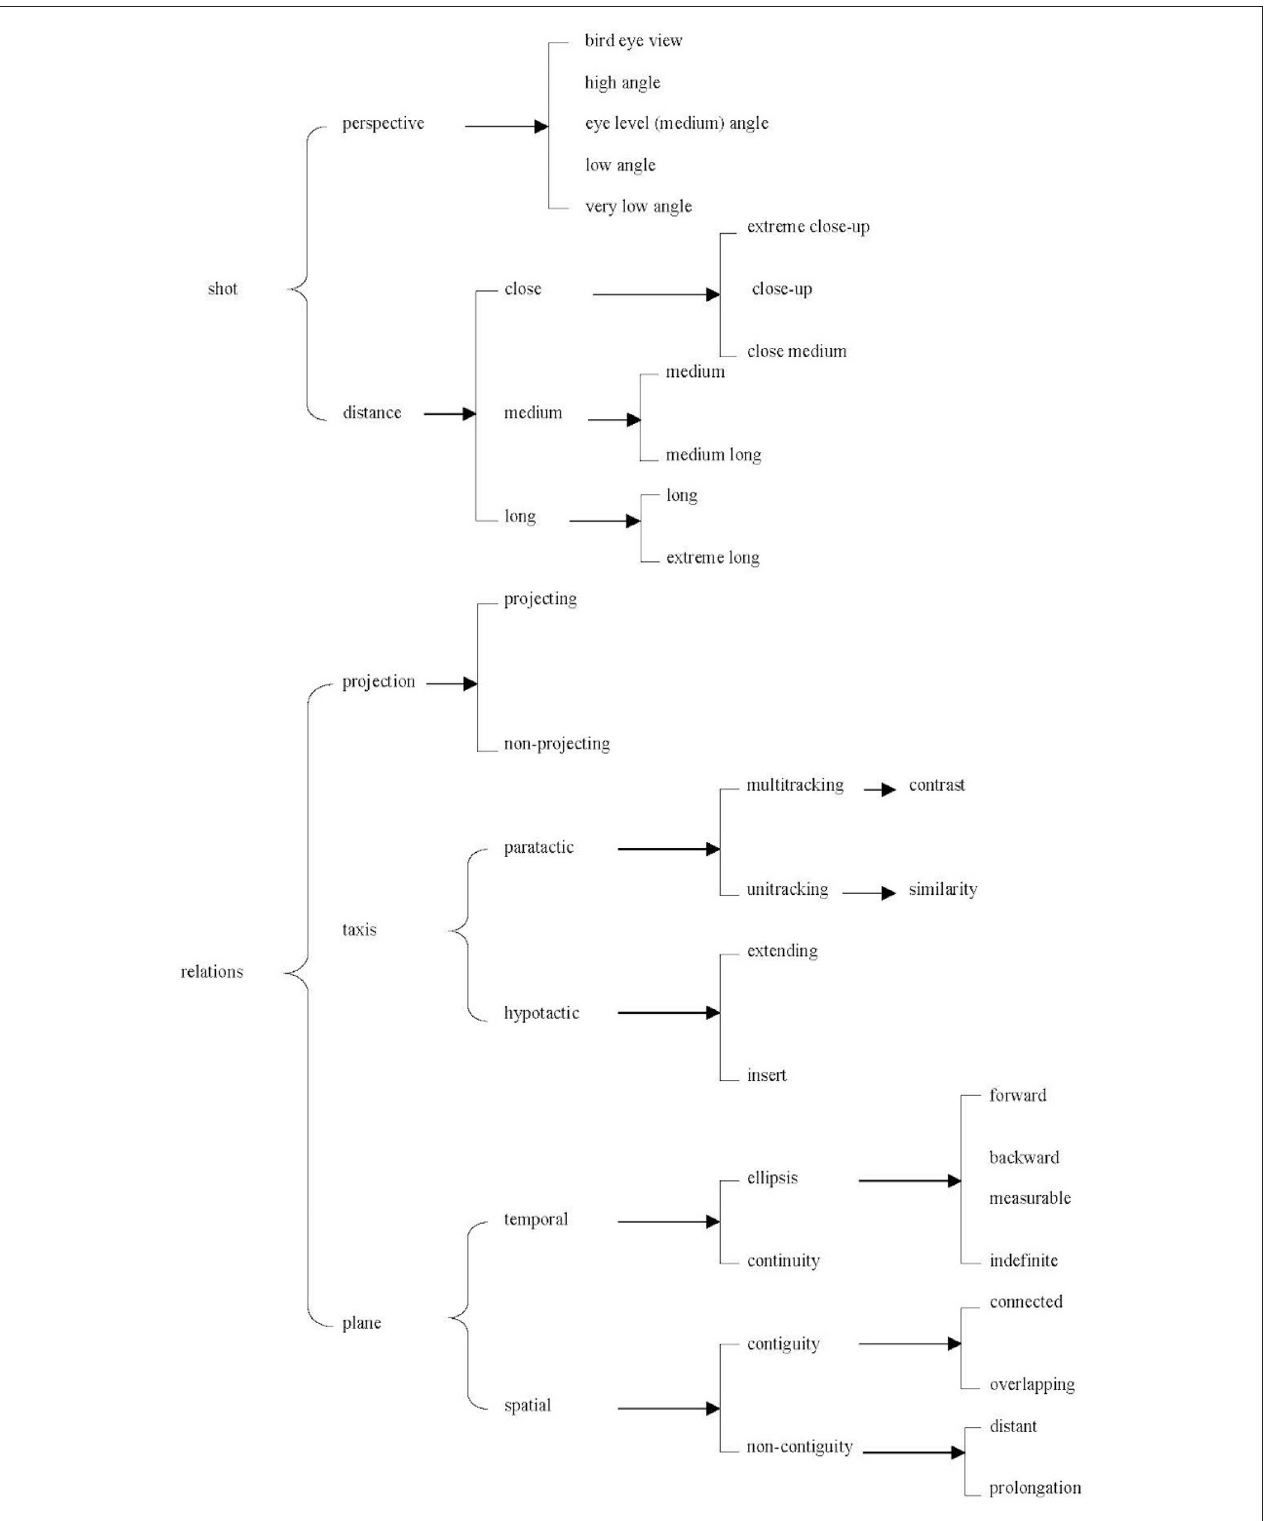
FIGURE 5 | System Network for the annotation of rhetorical relations between shots in the Heineken commercials.